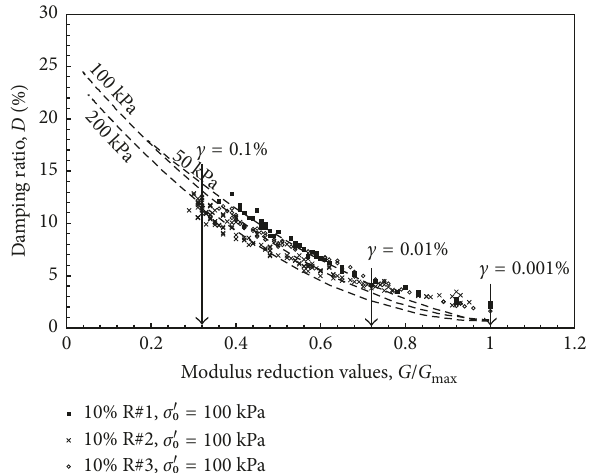
Figure 11: Relationship between shear modulus and damping ratio for 10% rubber content.